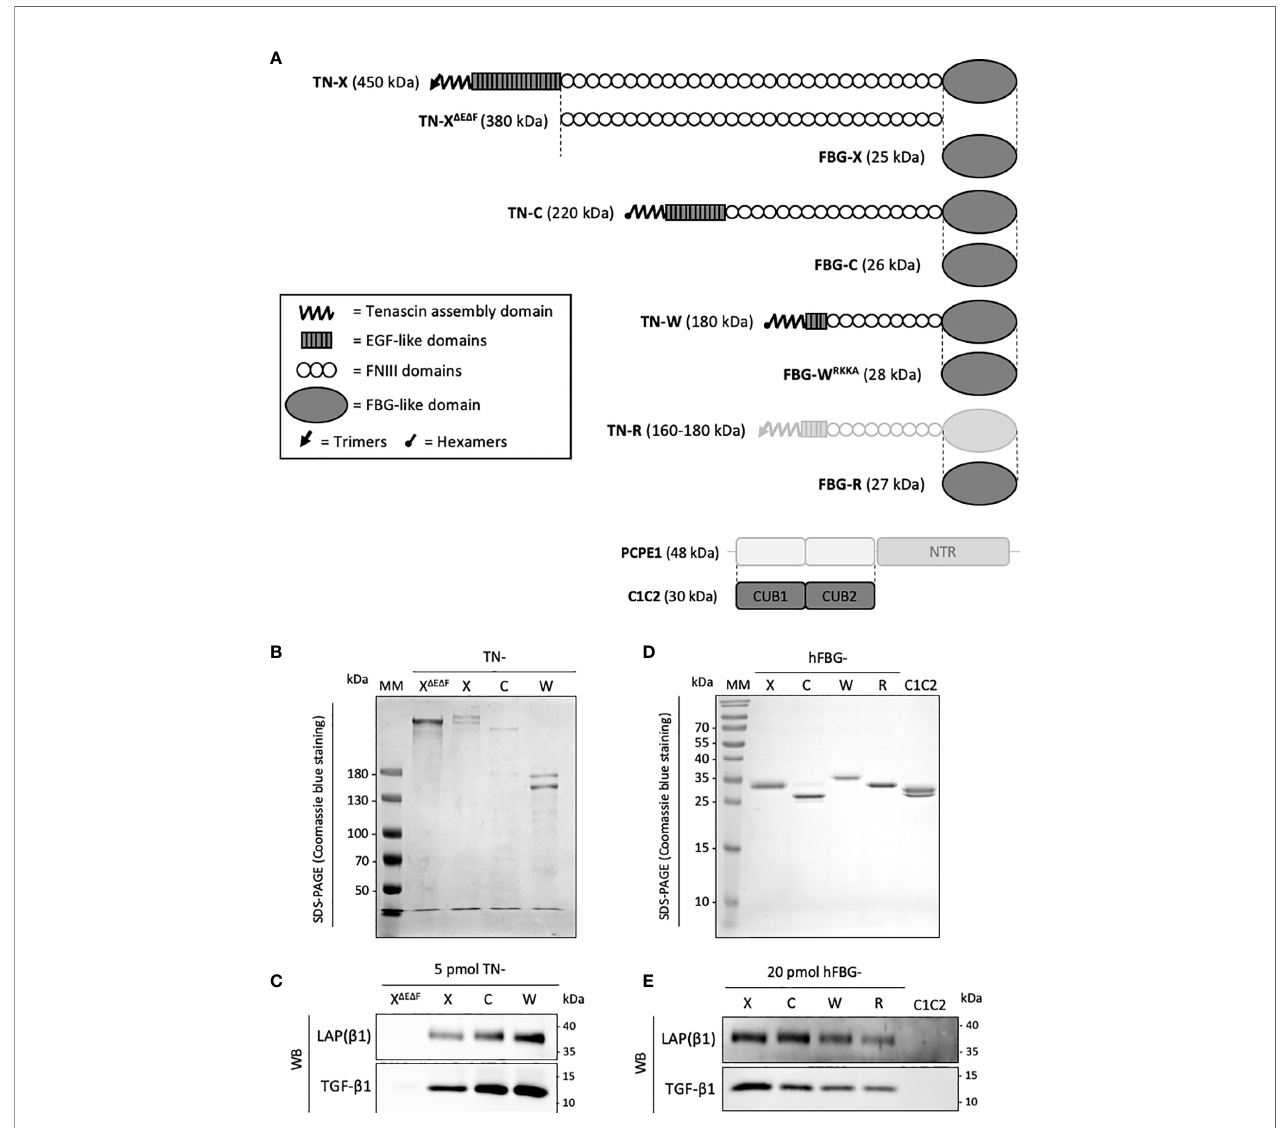
FIGURE 2 | Recombinant full-length Tenascins and their respective FBG-like domains co-purify with latent TGF- b 1. (A) Schematic representation of the recombinant proteins used in this study (dark grey). Structural modules of Tenascins are depicted in the inset. (B, D) SDS-PAGE analysis of the puri fi ed recombinant proteins and stained with Coomassie blue. MM, molecular mass markers. (B) Puri fi ed full-length TN-X, TN-C, TN-W and the TN-X D E D F fragment (1 m g each) were loaded on 6% acrylamide gels under reducing conditions. (D) Puri fi ed recombinant FBG-like domains of the four human Tenascins and the recombinant CUB1CUB2 (C1C2) domain (2 m g) were resolved on 15% acrylamide gels under reducing conditions. (C, E) Western blot analysis indicating the level of human mature TGF- b 1 and LAP ( b 1) pro-domain associated with equimolar quantity of puri fi ed recombinant full-length TN or TN-X D E D F fragment (5 pmol each) (C) and recombinant Tenascin FBG- like domains or CUB1CUB2 (C1C2) protein (20 pmol) (E)